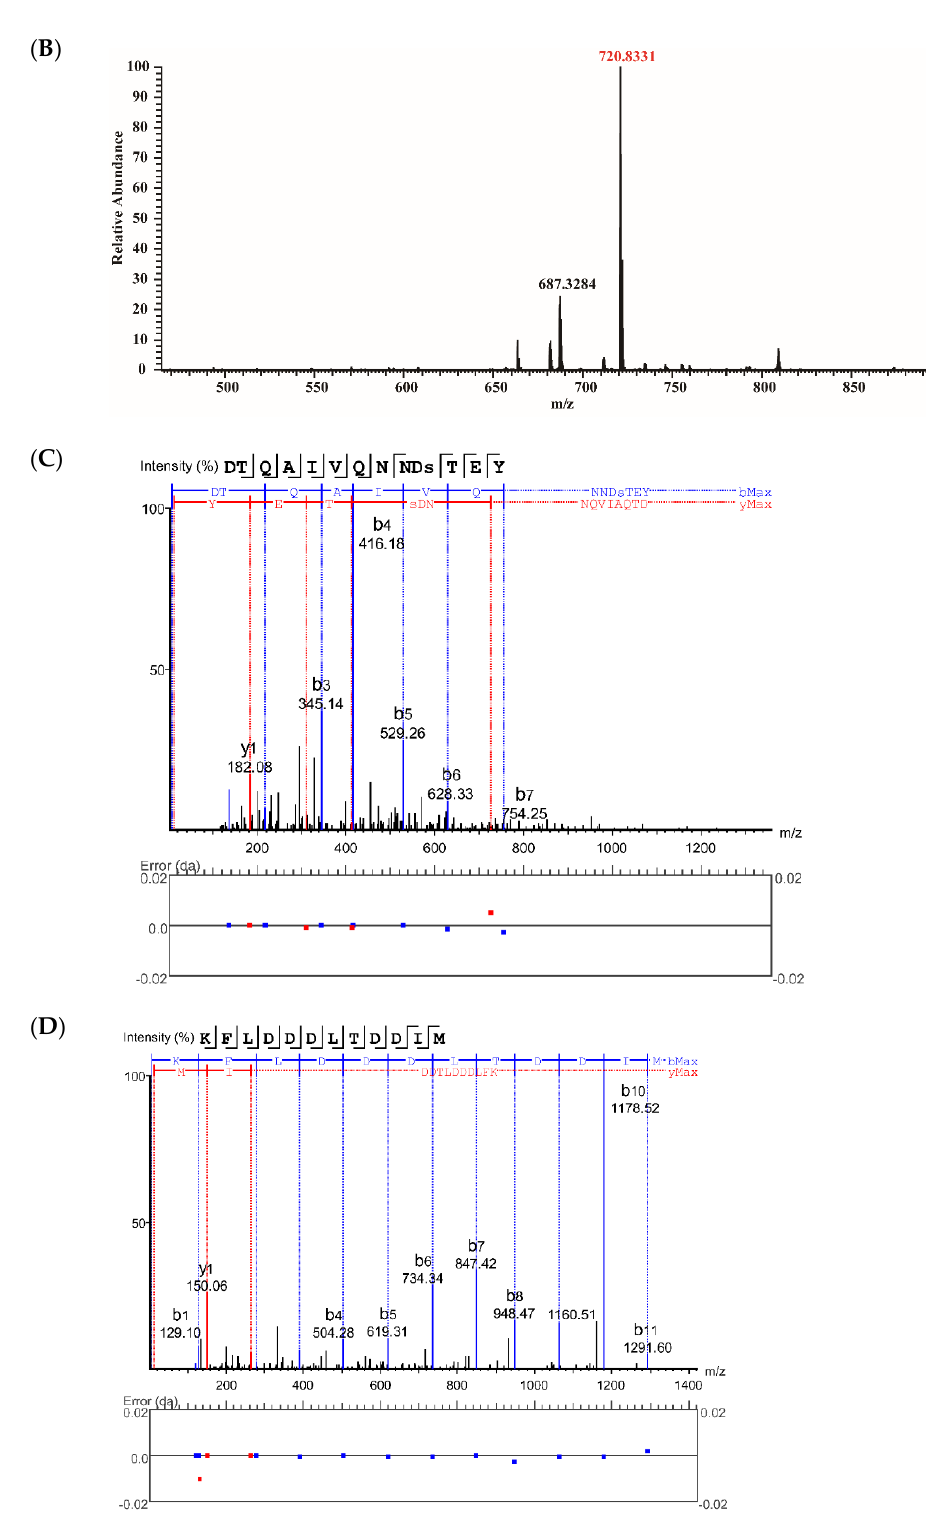
Figure 6. MS spectra of the anti-digestive stable peptides of DTQAIVQNNDSTEY and KFLDDDLTDDIM ( A , C ). HCD-MS/MS spectra of DTQAIVQNNDSTEY and KFLDDDLTDDIM ( B , D ).